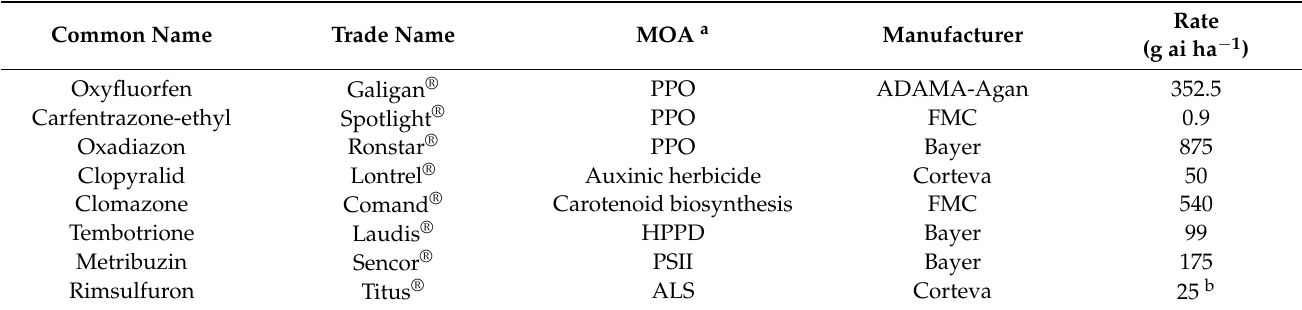
Table 3. List of herbicides used in this study and their labeled field